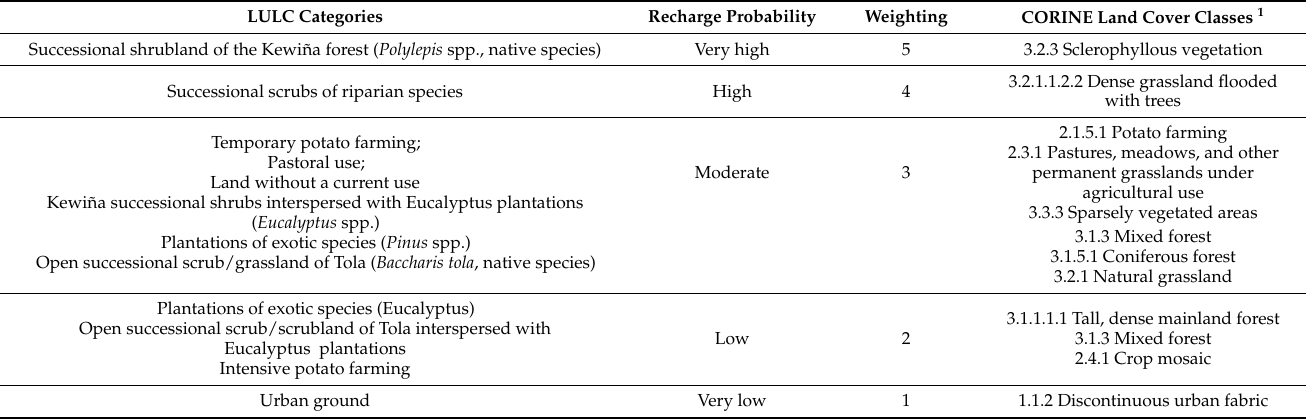
Table 3. Adjusted weighting and the probability of groundwater recharge according to specific land use and land cover categories found in the Virvini